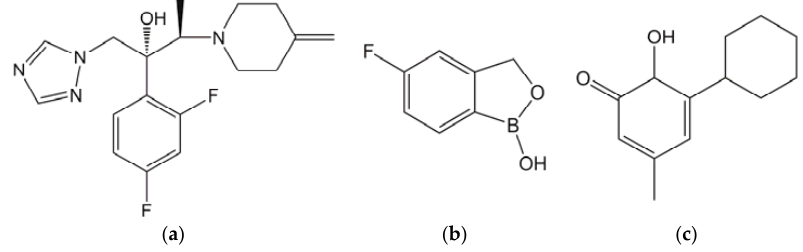
Figure 1. Chemical structures of efinaconazole ( a ), tavaborole ( b ), and ciclopirox ( c